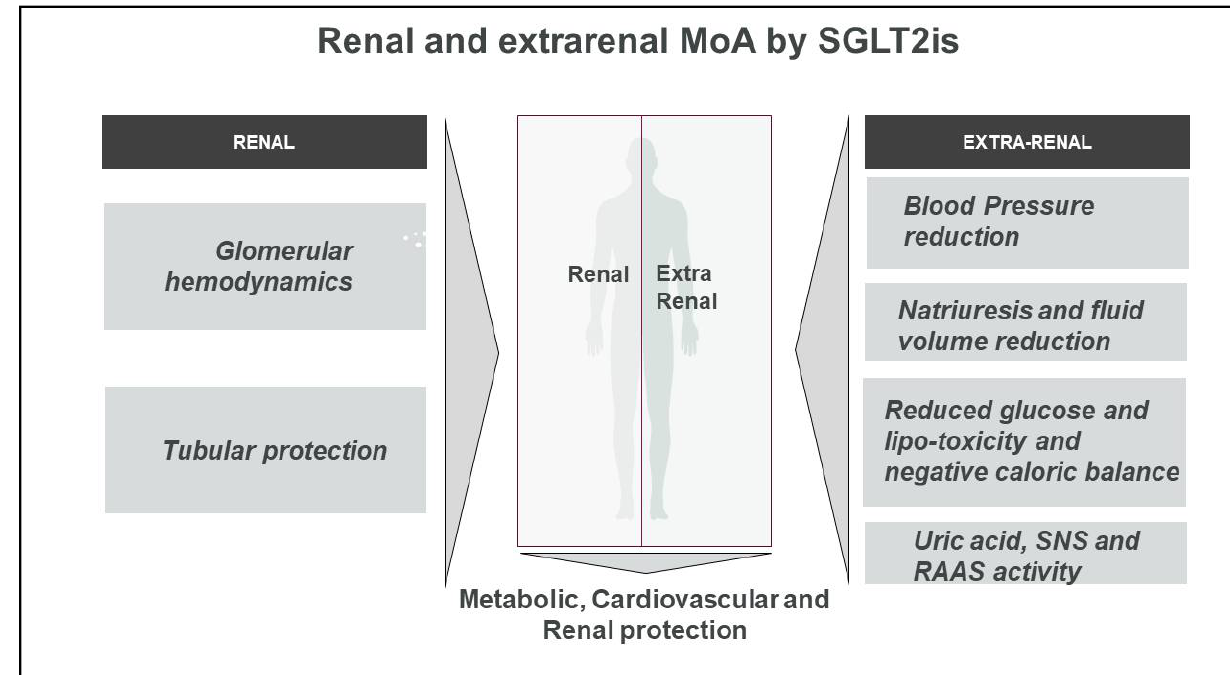
Figure 1. Renal and extrarenal mechanisms of action by SGLT2is. Selective inhibition of SGLT2 in proximal renal tubule prevents glucose reabsorption and entails several potentially favorable effects. Glycosuria concurs to euglycemia, lowers HbA1c, and reduces glucotoxicity, preserving beta cell function. As for extra-glycemic effects, SGLT2is promote diuresis and natriuresis and determine a mild reduction in extracellular fluid, especially interstitial fluid. Effective blood volume and blood pressure reduction ensues. Abbreviations: MoA, mechanisms of action; RAAS, renin angiotensin aldosterone system; SNS, sympathetic nervous system.